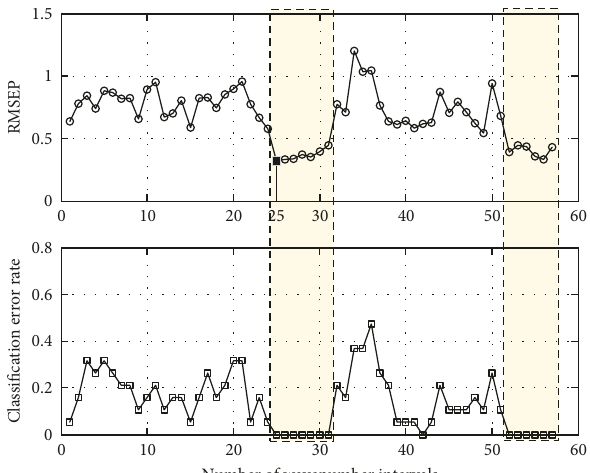
Figure 6: Variation of the classification performance of PLS-DA with spectral intervals for Class 1 and 2. RMSEP: root mean square error of prediction; PLS-DA: partial least squares discriminant analysis.